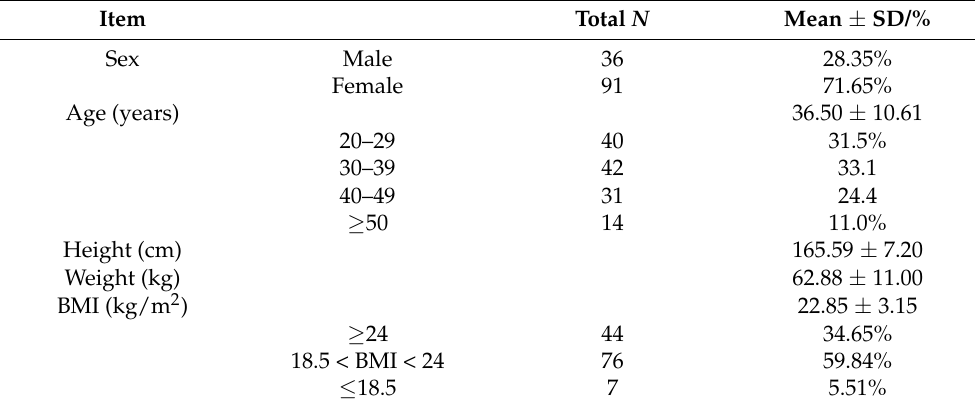
Table 1. Demographic characteristics of 127 COVID-19 vaccine